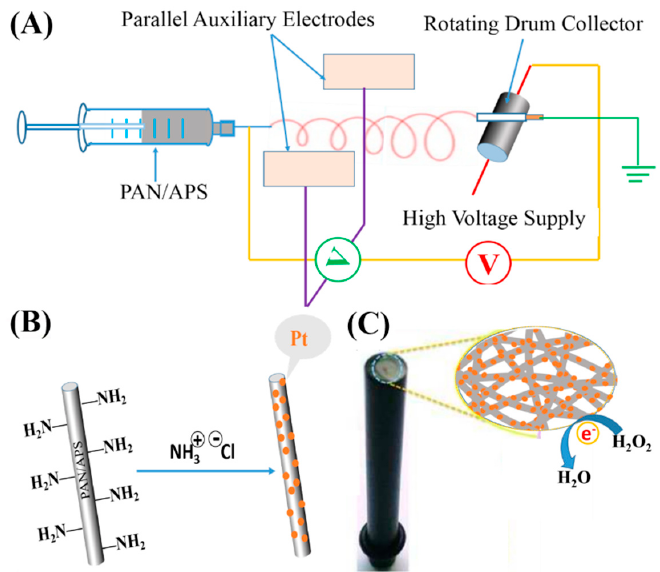
Figure 1. ( A ) Model of a home-made electrospinning instrument for the synthesis of polyacrylonitrile/3-aminopropyltriethoxysilane (PAN/APS) hybrid nanofibers; ( B ) Electrostatic assembly mechanism of platinum nanoparticles (PtNPs) along amino-modified PAN nanofibers; ( C ) PAN–PtNPs hybrid nanofibrous membrane-modified electrode and the potential sensing mechanism of H 2 O 2 .